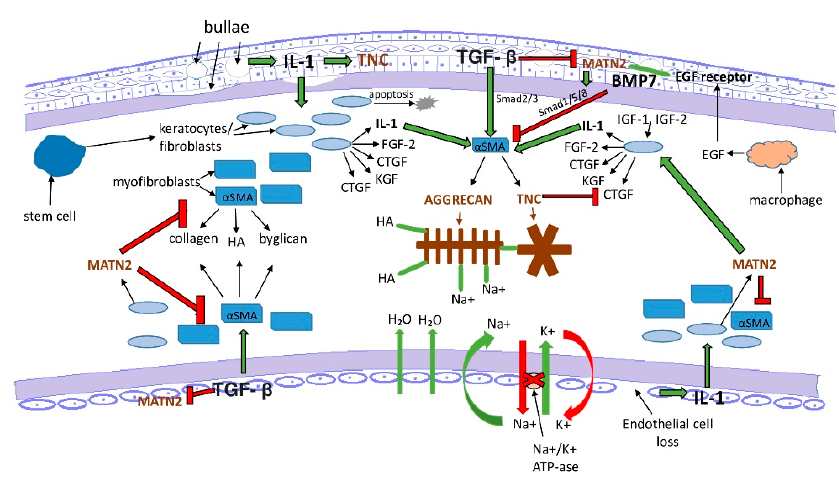
Figure 8. Proposed wound-healing mechanisms in PBK. The presence, distribution and the hypothesized bindings and effects of tenascin-C, matrilin-2 and aggrecan. α SMA = alpha smooth muscle actin, BMP7 = bone morphogenic factor 7, CTGF = connective tissue growth factor, EGF = epidermal growth factor, FGF-2= fibroblast growth factor 2, HA = hyaluron acid, IGF-1 = insulin-like growth factor 1, IGF-2 = insulin-like growth factor 2, IL-1 = interleukin-1, KGF = keratocyte growth factor, MATN2 = matrilin-2, TGF- β = transforming growth factor beta, and TNC = tenascin-C. Green arrows with black contour = positive trigger, red arrows with black contour = inhibition, and green line = bounding.